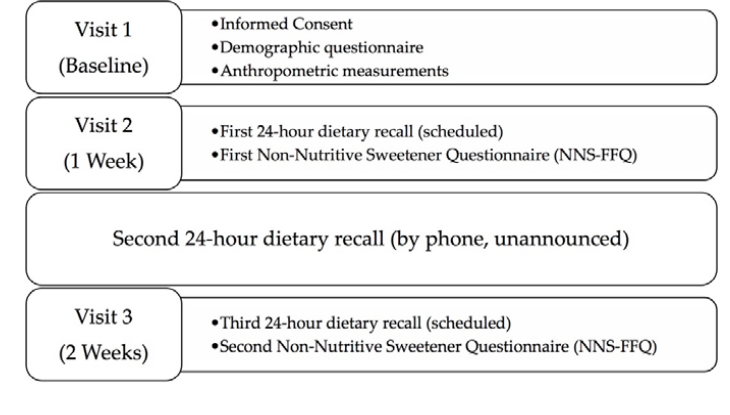
Figure 1. Study design and timeline.